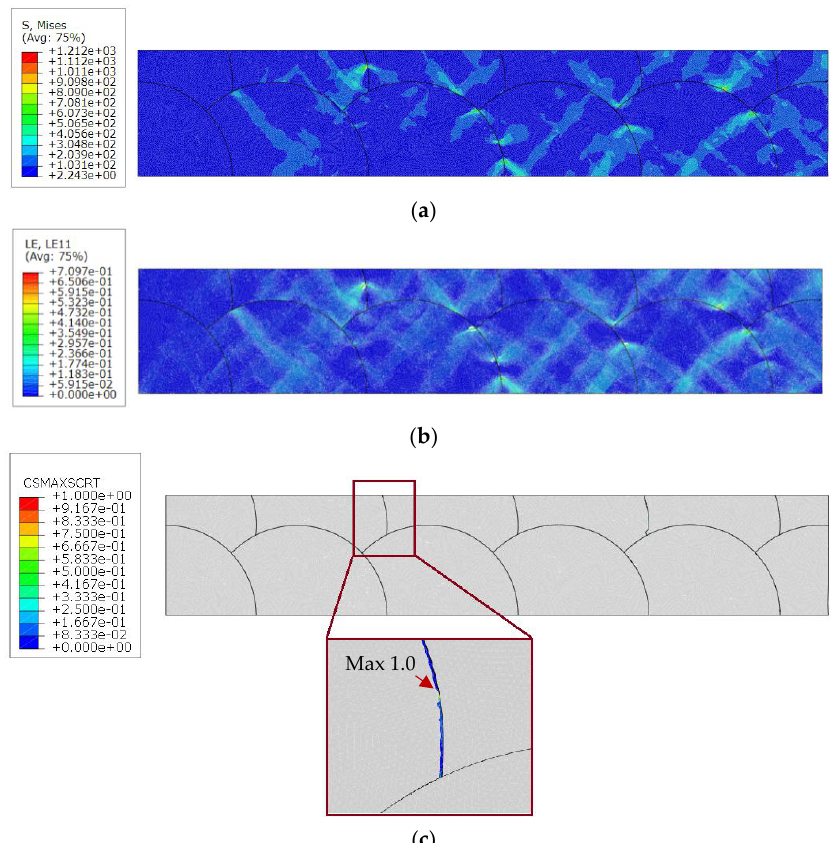
Figure 14. ( a ) Stress distribution for ℎ 0 = 150 𝑀𝑃𝑎,𝜏 0 = 50 𝑀𝑃𝑎,𝜏 𝑠 = 230 𝑀𝑃𝑎 − 12 𝑚𝑒𝑙𝑡 𝑝𝑜𝑜𝑙𝑠 ; ( b ) Strain distribution for ℎ 0 = 150 𝑀𝑃𝑎,𝜏 0 = 50 𝑀𝑃𝑎,𝜏 𝑠 = 230 𝑀𝑃𝑎 − 12 𝑚𝑒𝑙𝑡 𝑝𝑜𝑜𝑙𝑠 ; ( c ) Deformed configuration of melt pool of 𝑇 11 associated with the index of the quadratic stress damage criterion.